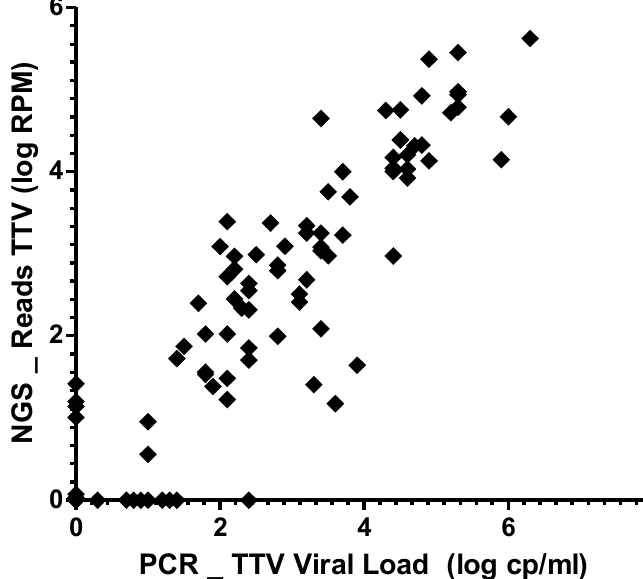
Figure 3. Correlation between the results of metagenomic NGS and TTV qPCR. Normalized number of reads obtained for torque teno virus (TTV) using mNGS are presented in function of the TTV viral load determined using qPCR. RPM: reads per million mapped reads.